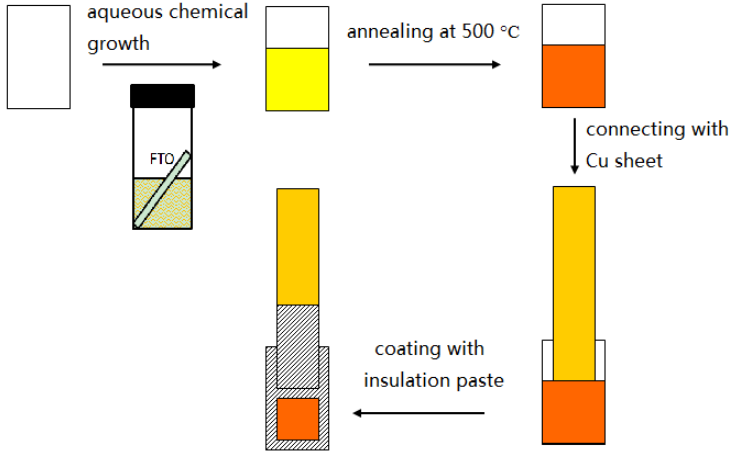
Figure 1. Schematic diagram of α-Fe 2 O 3 photoanode preparation.